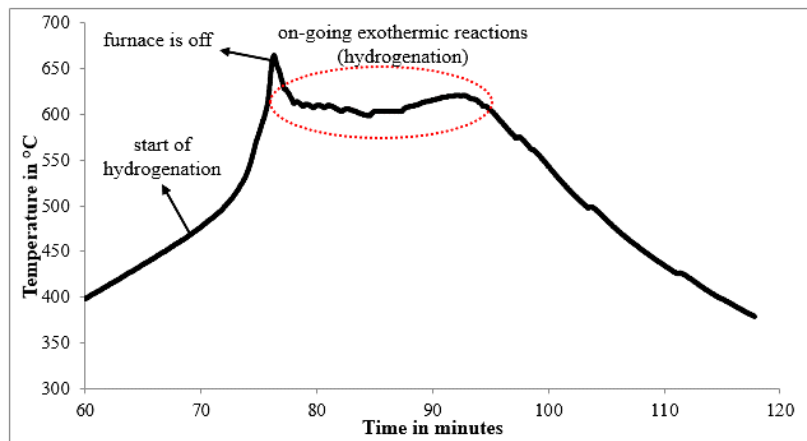
Figure 2. Temperature measurement time during hydrogenation of the Ti6Al4V turnings.